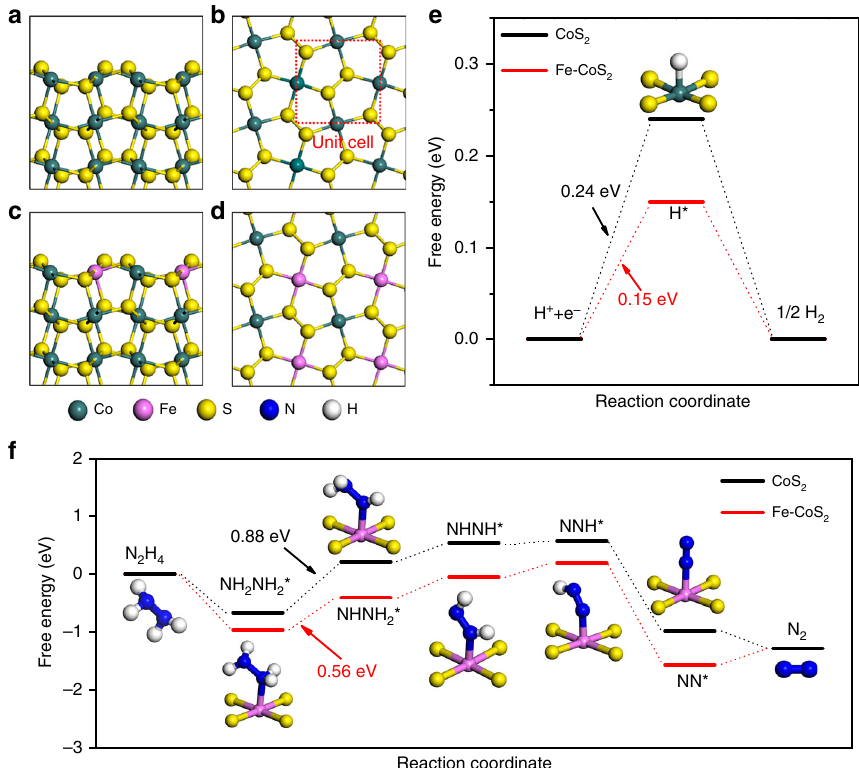
Fig. 5 Atomic structure models of DFT-relaxed pure CoS 2 (001) and Fe-CoS 2 (001) surfaces and their calculated pro fi les of free energy for HER and HzOR. a , b Side- and top-view images of the CoS 2 surface. c , d Side- and top-view images of the Fe-CoS 2 surface. e Free energy pro fi les of HER on the CoS 2 and the Fe-CoS 2 surfaces at 0 V vs RHE. The inset in e is the most stable con fi guration of the intermediate (H*) adsorbed on the surface of CoS 2 . The most stable H* con fi guration on the Fe-CoS 2 surface is very close to the one in the inset (see details in Supplementary Fig. 29). f Free energy pro fi les of HzOR on the CoS 2 and the Fe-CoS 2 surfaces at 0 V vs RHE. The insets in f are the N 2 H 4 and N 2 molecular models and the most stable con fi gurations of the adsorbed intermediates on the Fe-CoS 2 surface (see more details in Supplementary Fig. 32). Please see Supplementary Fig. 34 for the most stable con fi gurations of the adsorbed intermediates on the CoS 2 surface. The numbers with eV in e , f are the maximum values of positive changes of free energies in the corresponding HER and HzOR processes. The reason to choose (001) is that Fig. 1a indicates the preferential orientation of the nanosheets to be